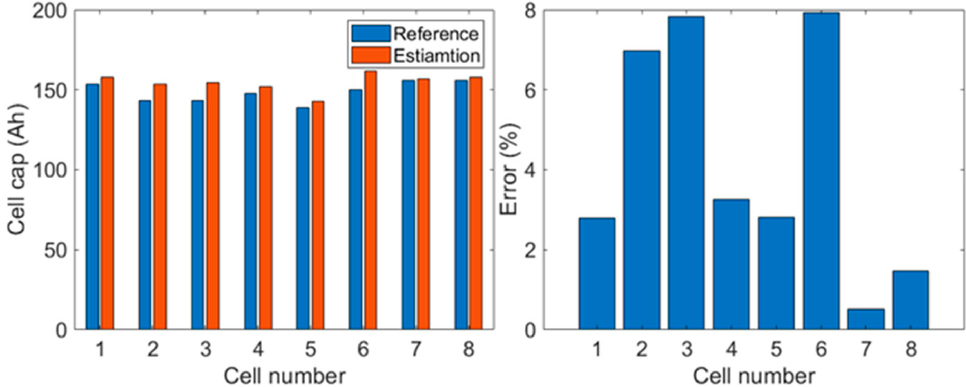
Figure 16. Estimation results and estimation error with curve-matching method (aged data).